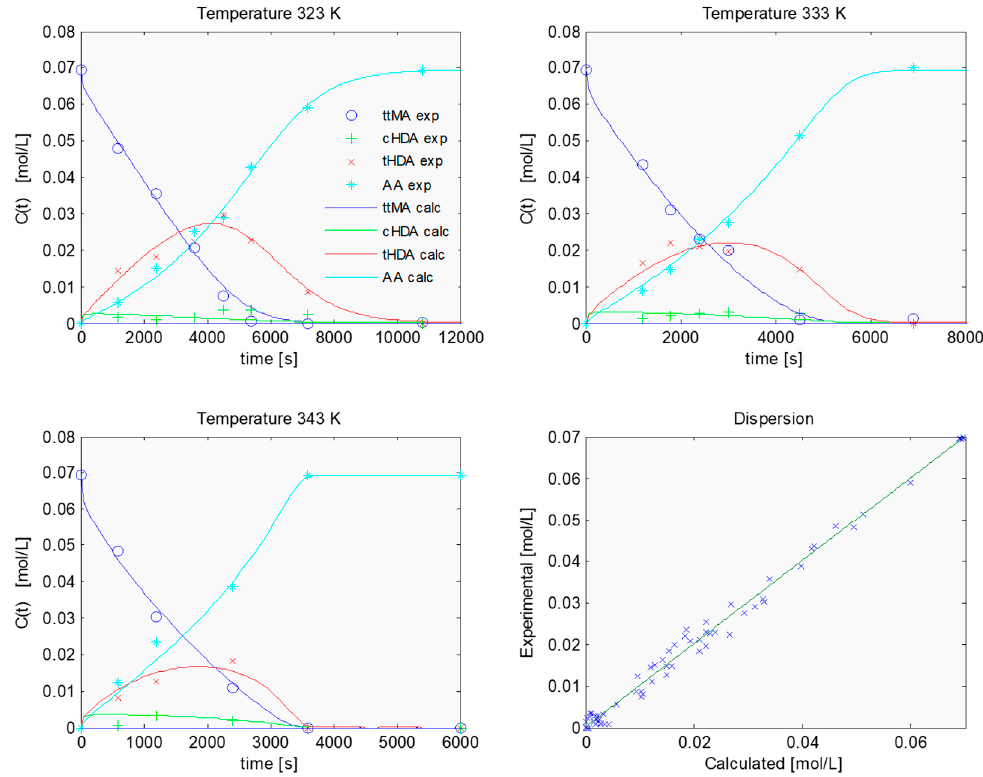
Figure 2. Results of the regression with the model LHHW_17P.